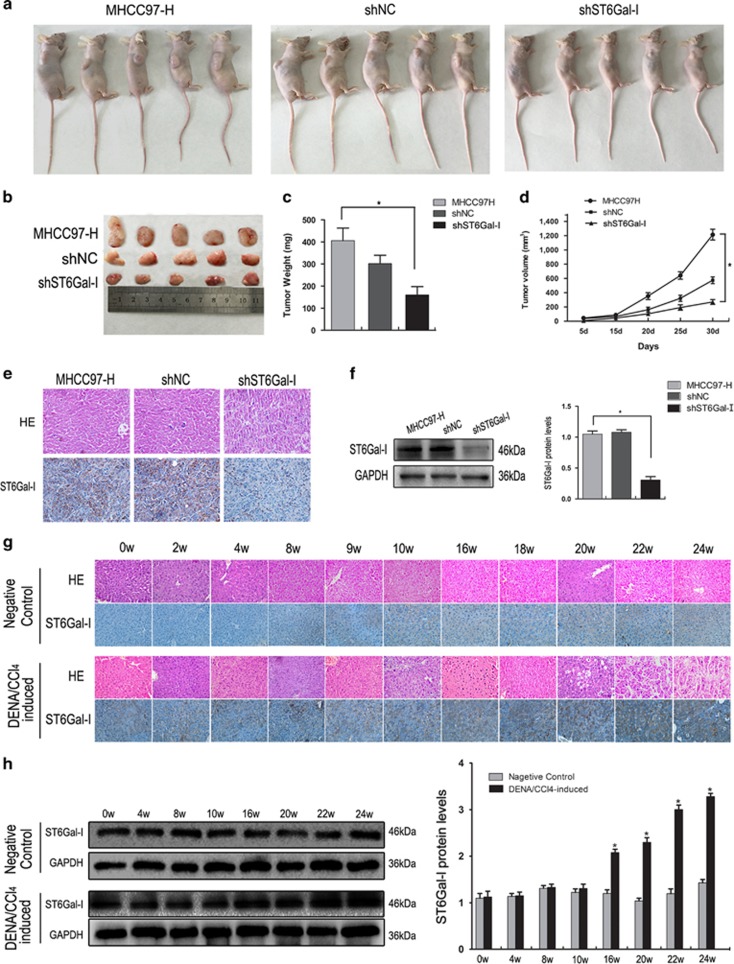
ST6Gal-I promotes liver tumorigenicity in mice. (a, b) Morphological images of tumors formed after 30 days; representative results are shown. (c, d) Average tumor weights and sizes were measured in different groups. *P<0.05. (e, f) Differential expression of ST6Gal-I in the experimental group, negative control group and matched group as examined by IHC and western blot analysis. *P<0.05. (g, h) IHC and western blot analysis showed that ST6Gal-I expression significantly increases during different periods of DENA-induced liver tumorigenesis.